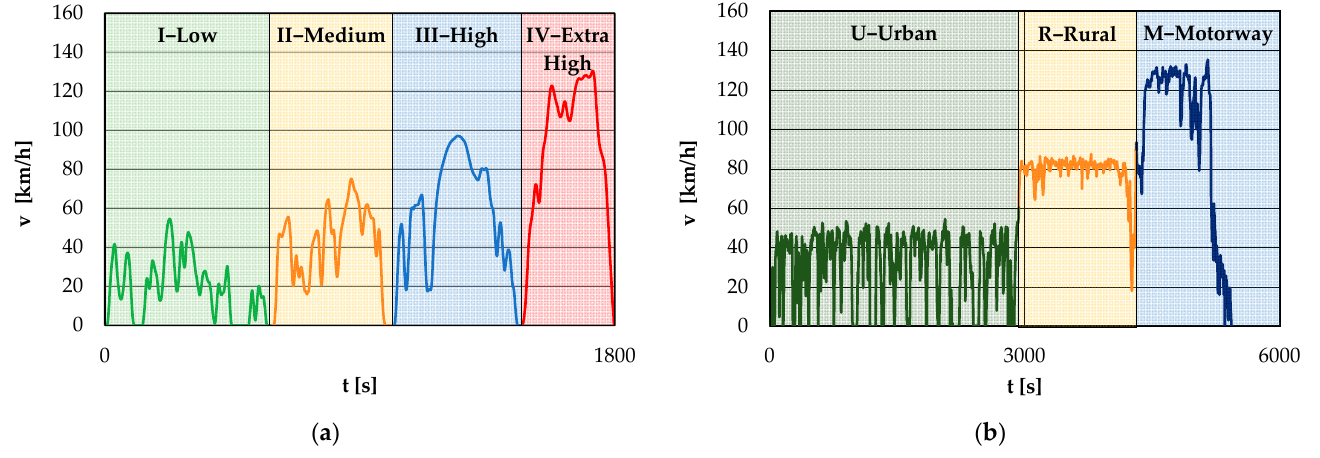
Figure 1. Vehicle speed curve (v) from the: ( a ) WLTC test; ( b ) RDE test.